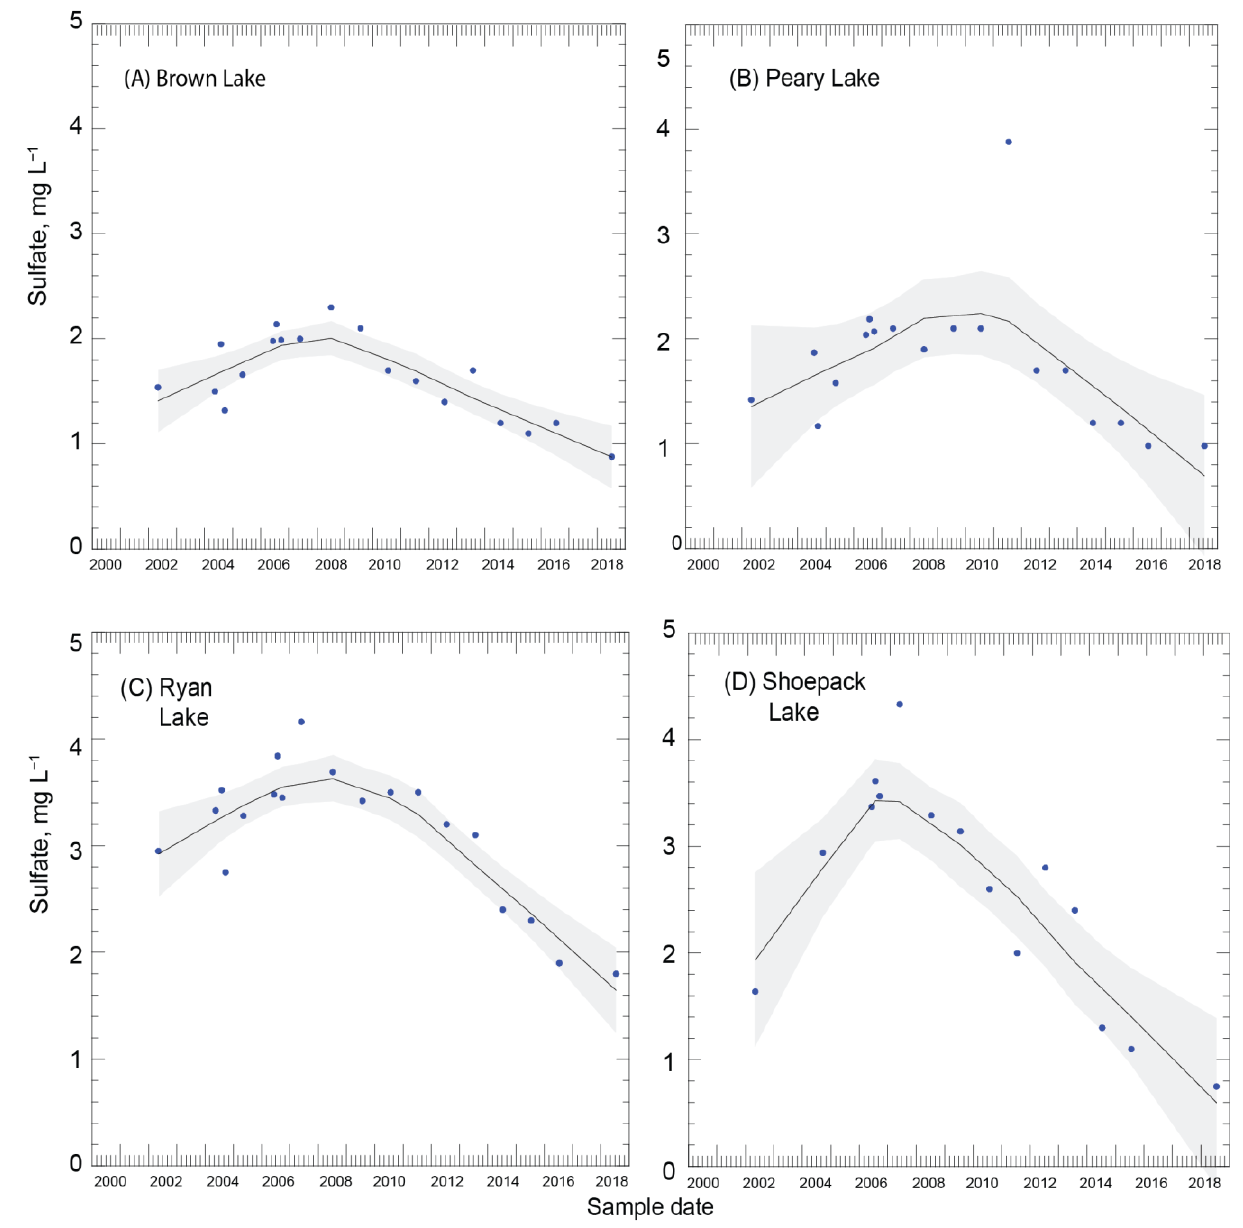
Figure 5. Time series plots for sulfate in epilimnetic lake water. Smooth lines are locally weighted regression lines; smoothing parameters, selected as described in the methods section: ( A ) Brown Lake, smoothing parameter = 0.711; ( B ) Peary Lake, smoothing parameter = 0.75; ( C ) Ryan Lake, smoothing parameter = 0.711; and ( D ) Shoepack Lake, smoothing parameter = 0.70. Gray shading indicates the 95-percent confidence interval.